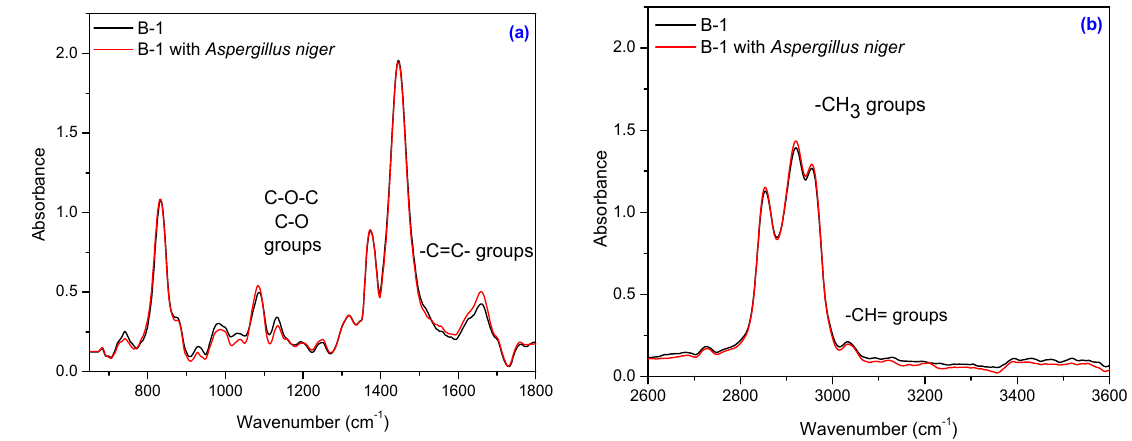
Figure 13. Infrared spectrum of the B-1 sample: ( a ) in the range of 650–1800 cm − 1 and ( b ) in the range of 2600–3600 cm − 1 .